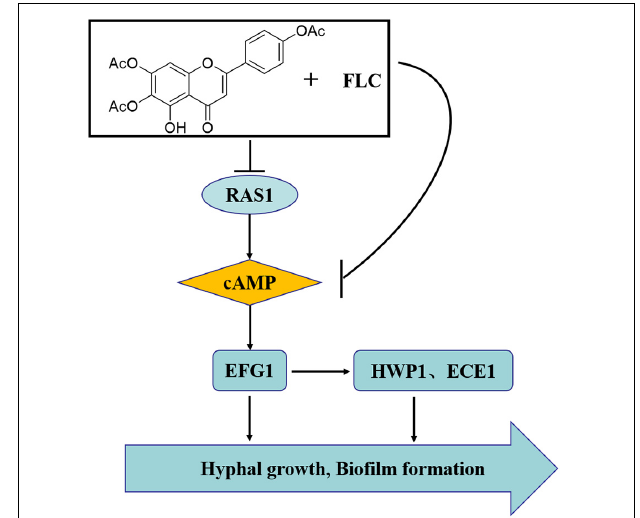
FIGURE 10 | The synergistic mechanism of TA combined with FLC against C. albicans . The synergistic mechanism may be related to the changes of downstream hyphae-related genes caused by the RAS-cAMP-PKA pathway inhibition.